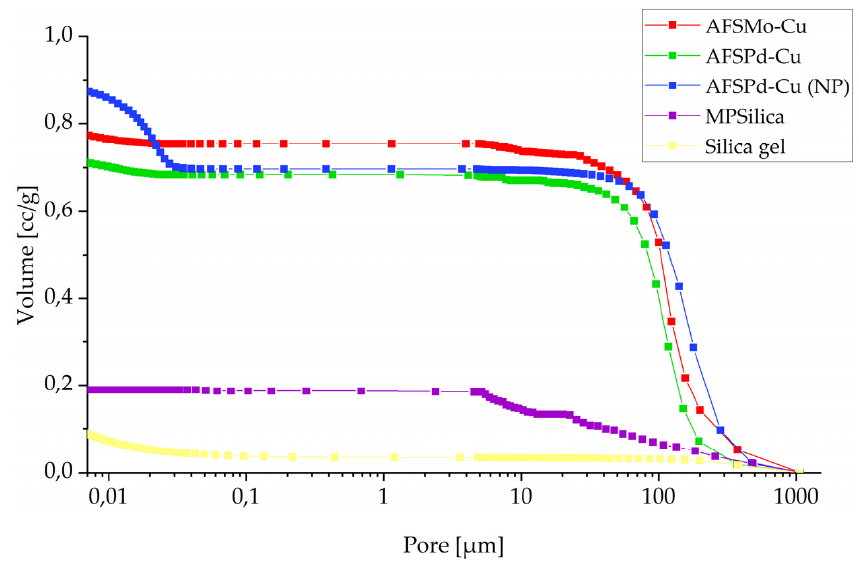
Figure 4. Cumulative pore volume determined using mercury intrusion porosimetry.